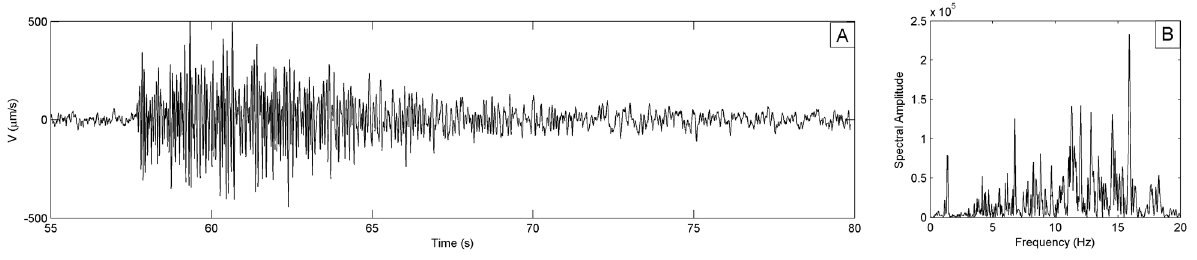
= 0.4 VT recorded on December 19, 1999, at BKE station (vertical D